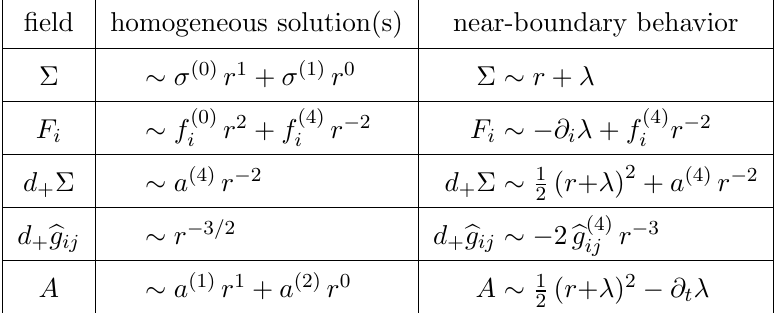
, and g (4) determine respectively the energy b i ij